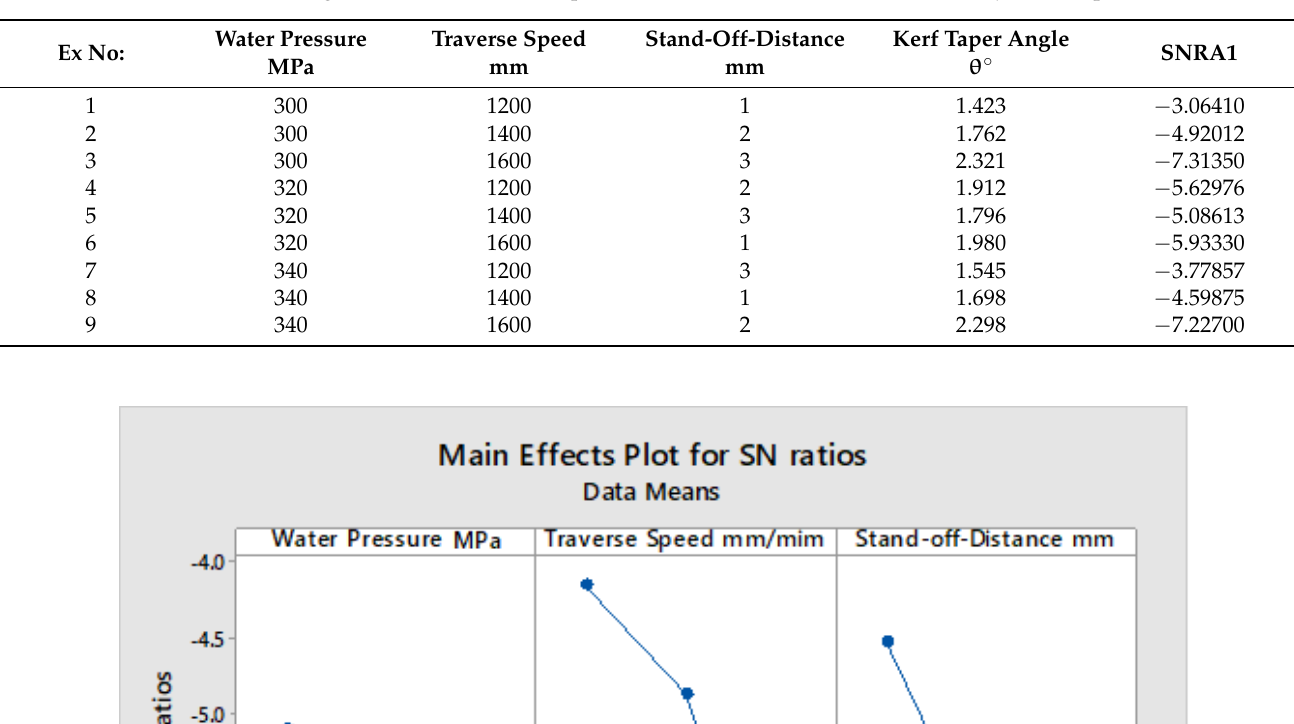
Table 22. L9 array of input parameter levels with measured kerf taper angle θ ◦ in degrees and calculated signal-to-noise (S/N) ratio based on the Taguchi method for 6 mm specimen thickness cut with abrasive water jet technique.